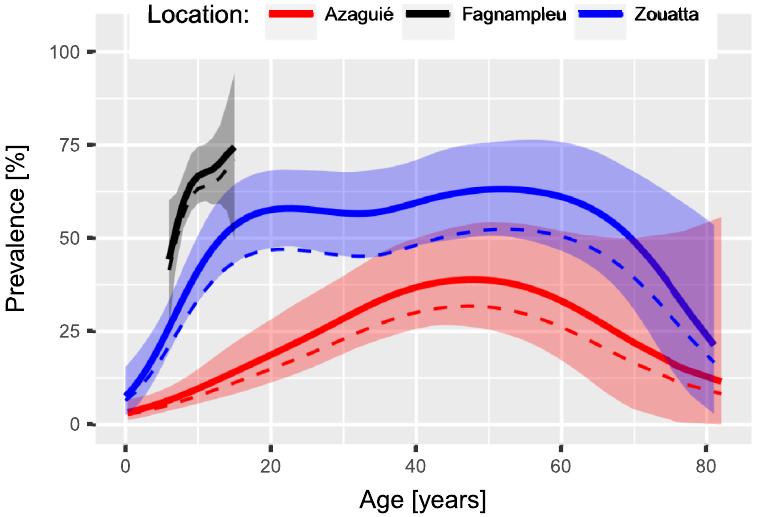
Fig 1. Prevalence of hookworm infection in relation to age for the three studies in Coˆte d’Ivoire, including 95% BCI indicated by shaded areas, and observed prevalence as dashed line.